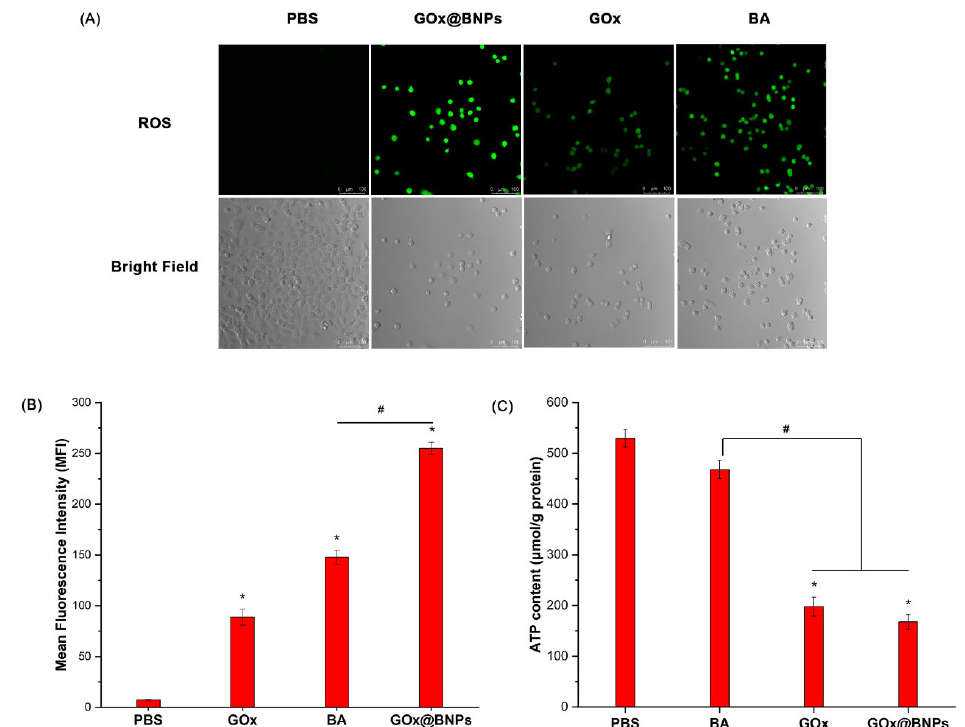
Figure 7. ( A ) ROS measurement in A549 cells using the DCFH-DA probe after incubation with different groups at 37 ◦ C for 2 h. Scale bars: 100 µ m. ( B ) The corresponding mean fluorescence intensity (MFI) after incubation with different groups (* p, # p < 0.05). ( C ) Intracellular ATP levels of A549 cells after treatment with different groups at 37 ◦ C for 12 h (* p, # p < 0.05). Results are expressed as the mean ± S.D. ( n = 3 ).